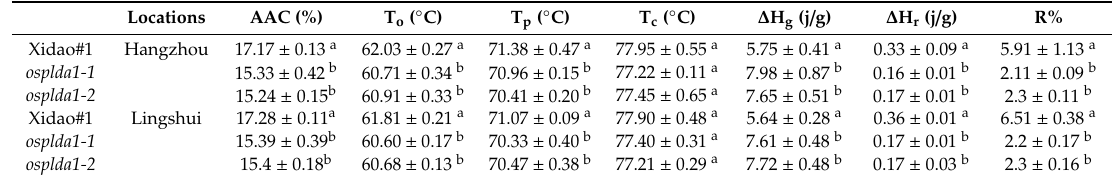
Table 1. Apparent amylose content, gelatinization and retrogradation properties of brown rice flour obtained from grains of plants grown at two